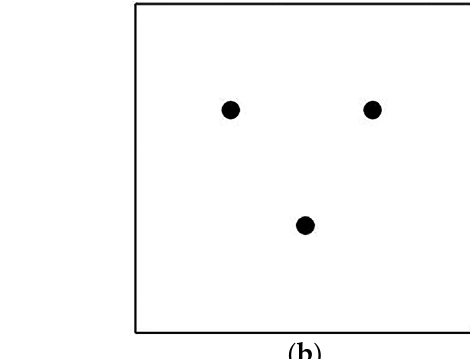
Figure 7. Schematic layout of measurement point: ( a ) inside of wall panel; ( b ) outside of wall panel. Note: The heat flow meters and thermocouples are represented by rectangles and circles, respec- tively.